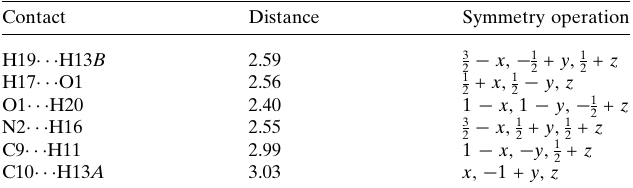
Table 3 Experimental details.